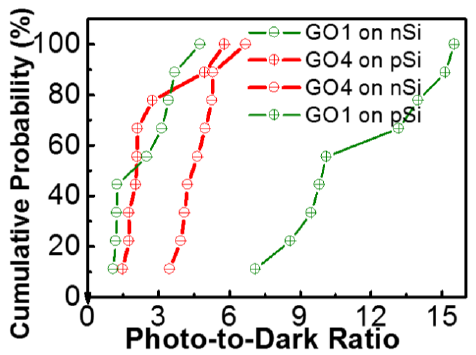
Figure 7. Cumulative probability plot of photo-to-dark ratios. On p-Si, GO1 results in larger ratios than those of GO4, whereas GO1 leads to smaller ratios on n-Si.